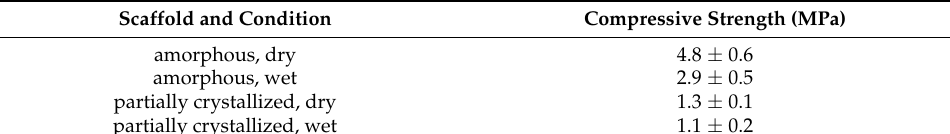
Table 2. Compressive strength of dry scaffolds after sintering and of wet scaffolds after 5 min immersion in SBF. The markings amorphous and crystallized refer to scaffolds sintered for 630 ◦ C for 60 min and 720 ◦ C for 90 min, respectively.